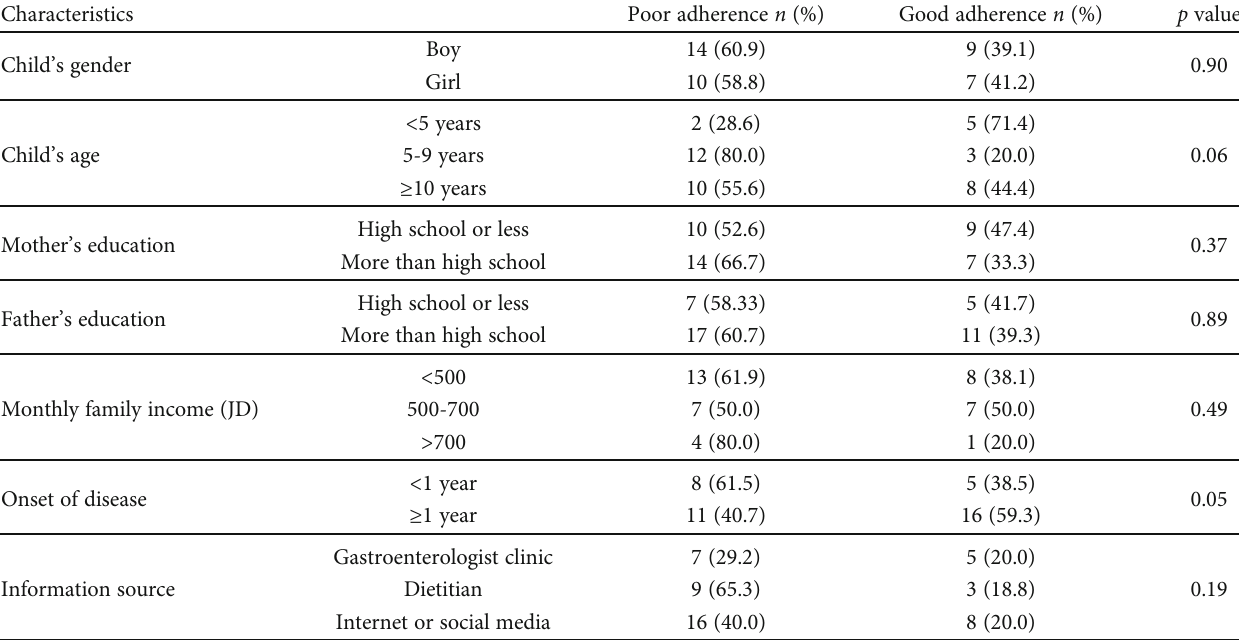
Table 4: Relationship between patient ’ s adherence categories and the sociodemographic characteristics of CD patients and their parents. Characteristics